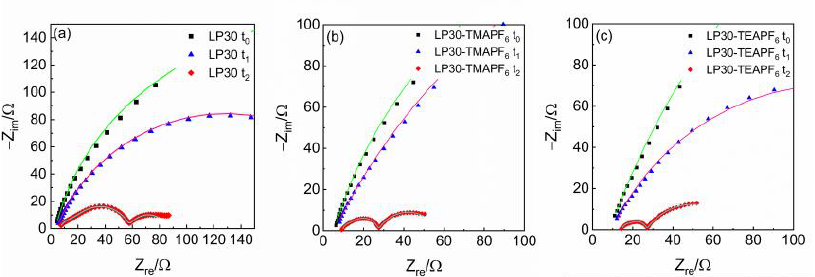
Figure A1. Enlarged view at high frequency of the Nyquist plot of Figure 5a,c,d. The green, red and cyan lines in the figures are the fitting results for the t 0 , t 1 and t 2 plots, respectively.